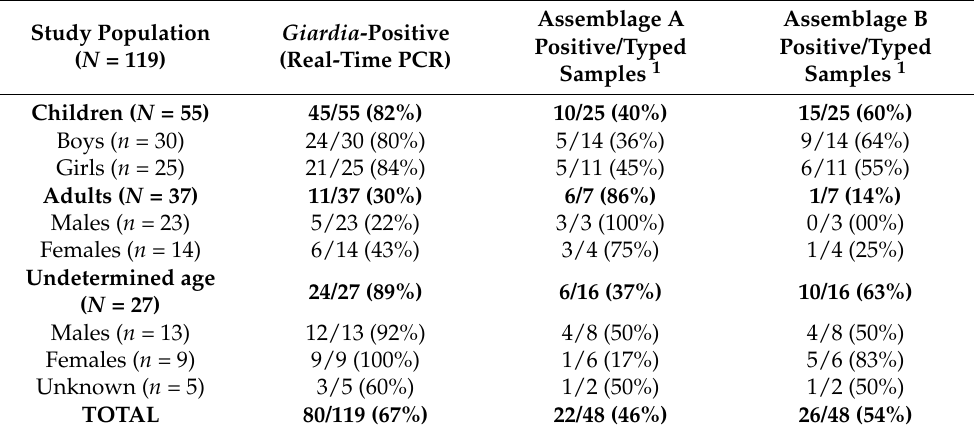
Table 2. Summary of Giardia assemblages detected by tpi gene analysis according to the basic demographic characteristics of the study